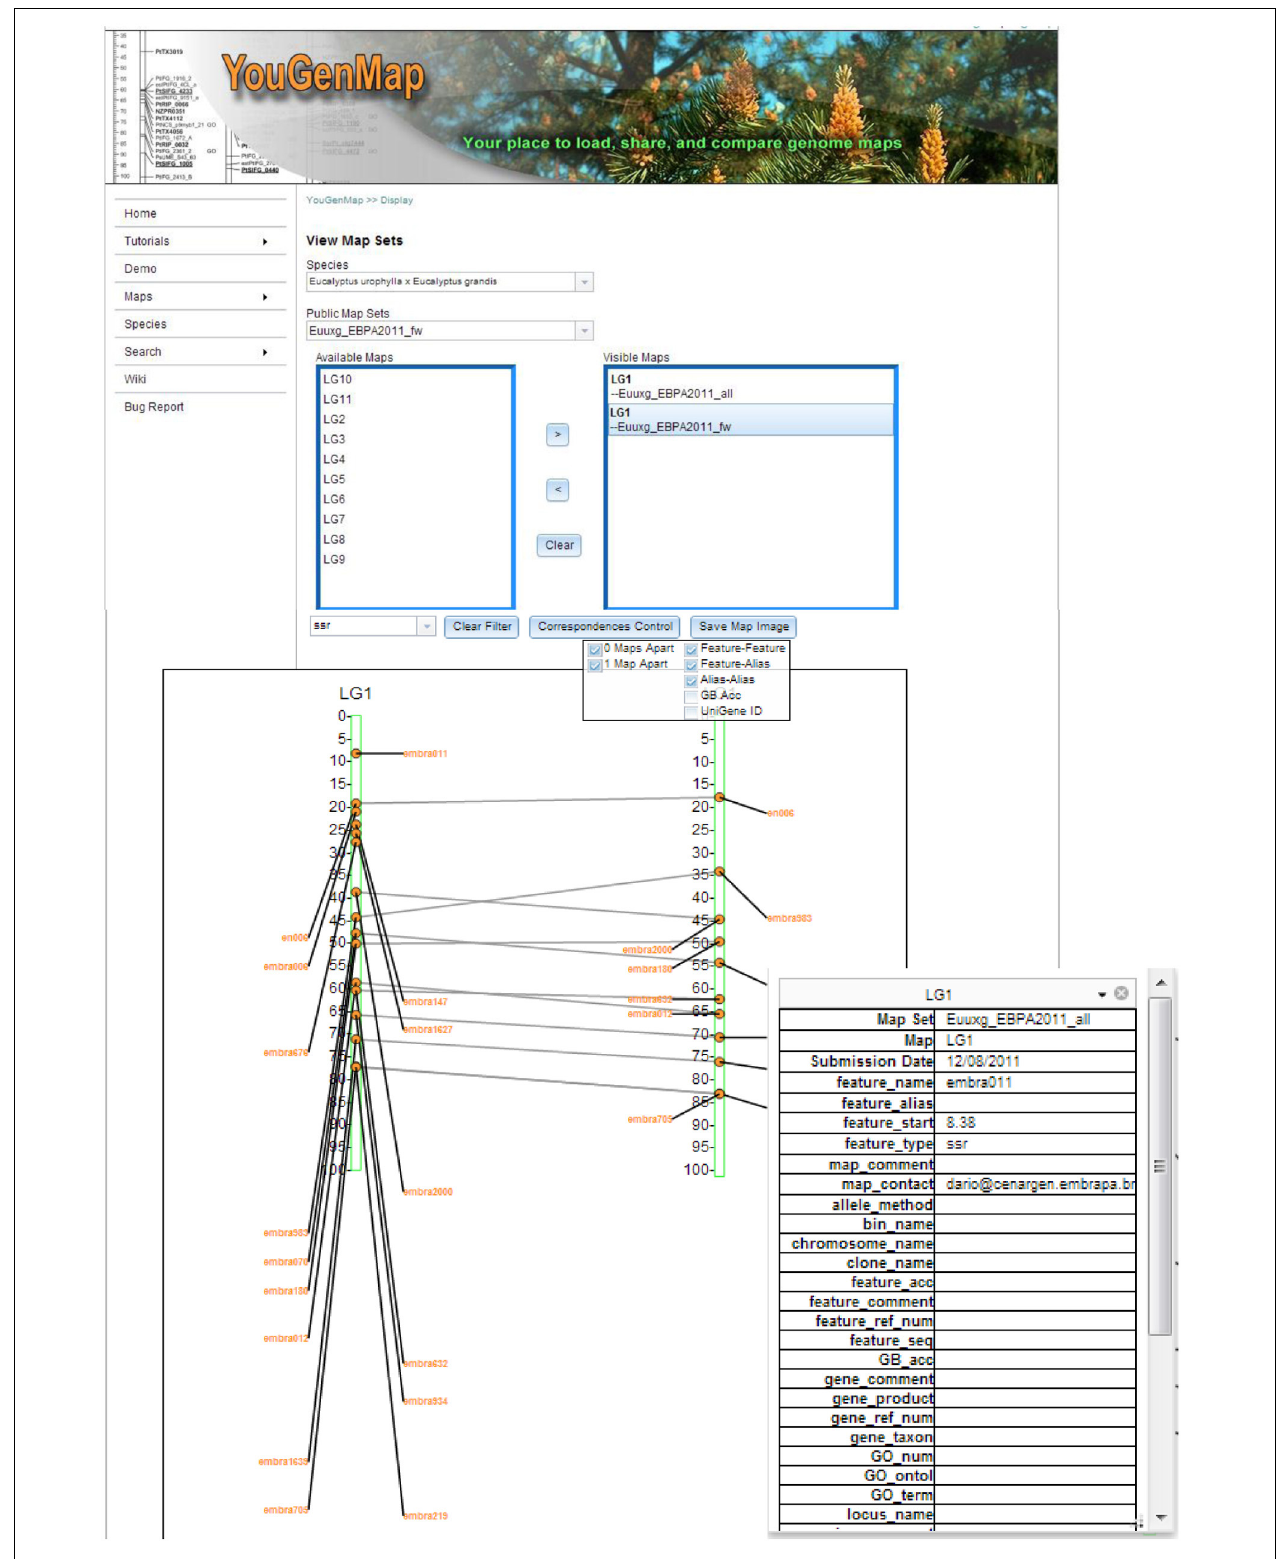
FIGURE 1 | A snap-shot of YouGenMap web interface that shows comparative